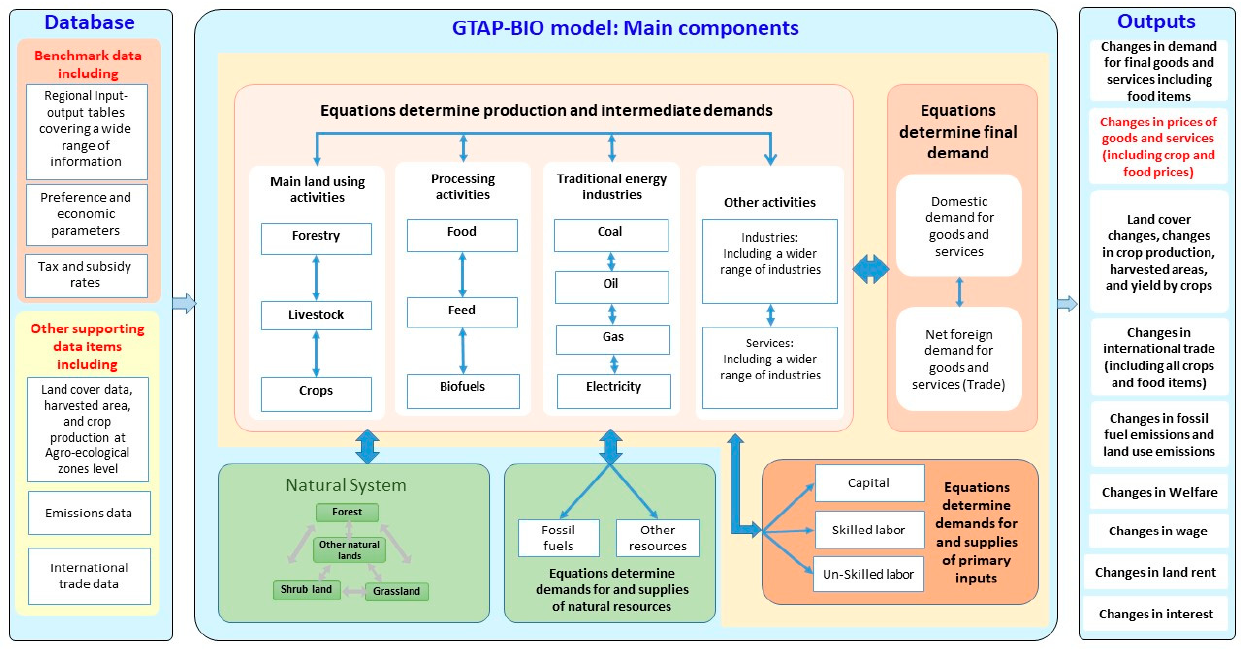
Figure 1. Main components of GTAP-BIO model .